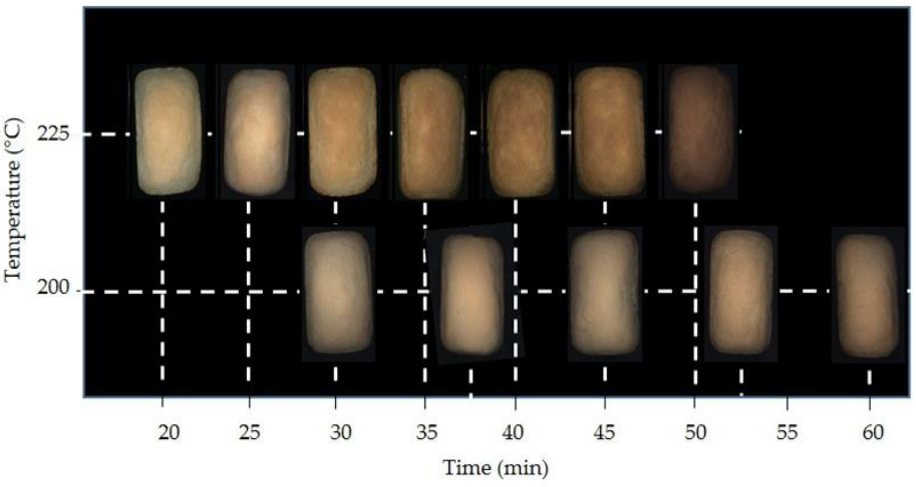
◦ C and 225 ◦ C for different baking times. Foods 2021 , 10 , x FOR PEER REVIEW